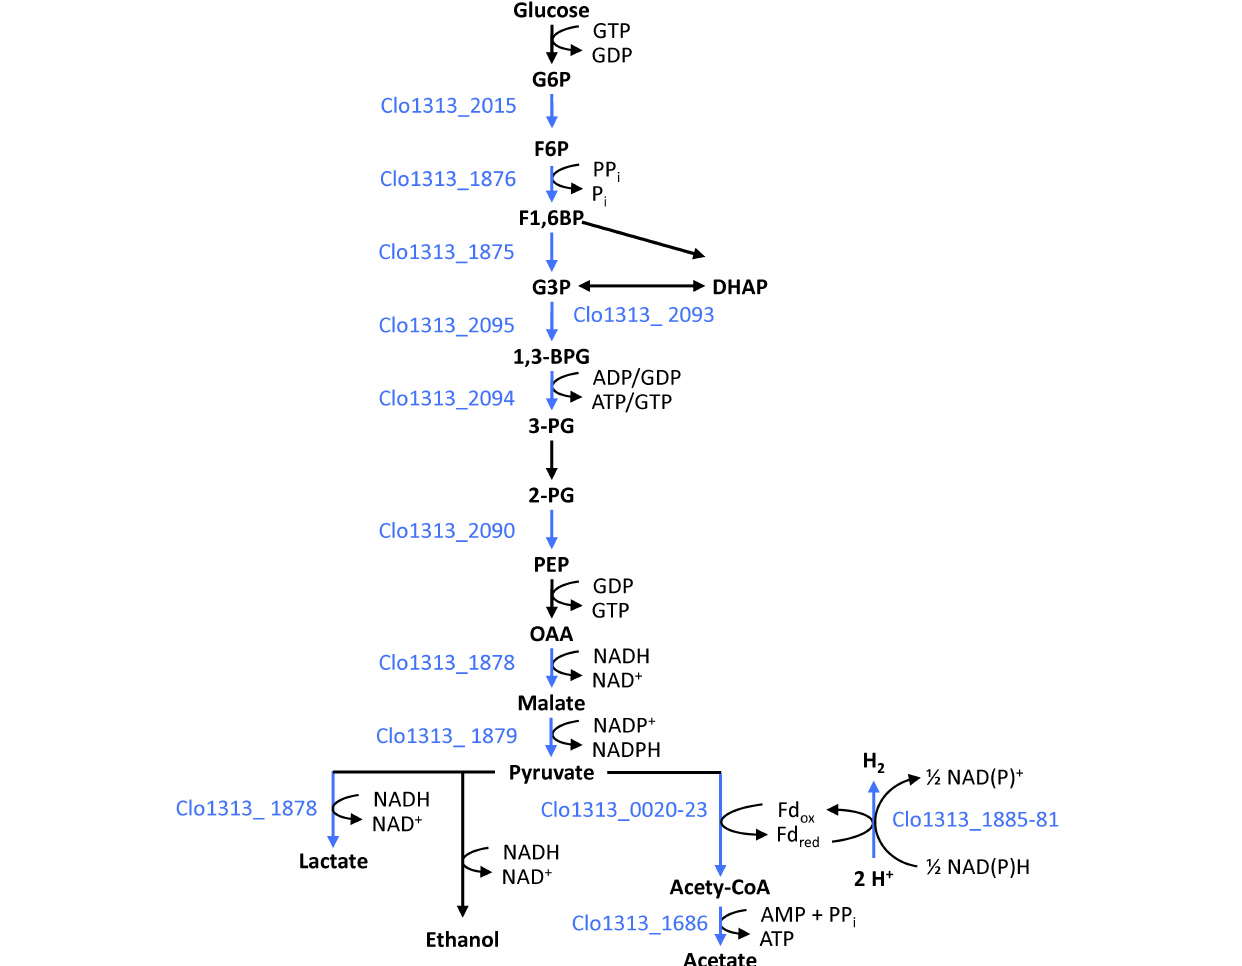
dehydrogenase (Clo1313_1878), two short-chain